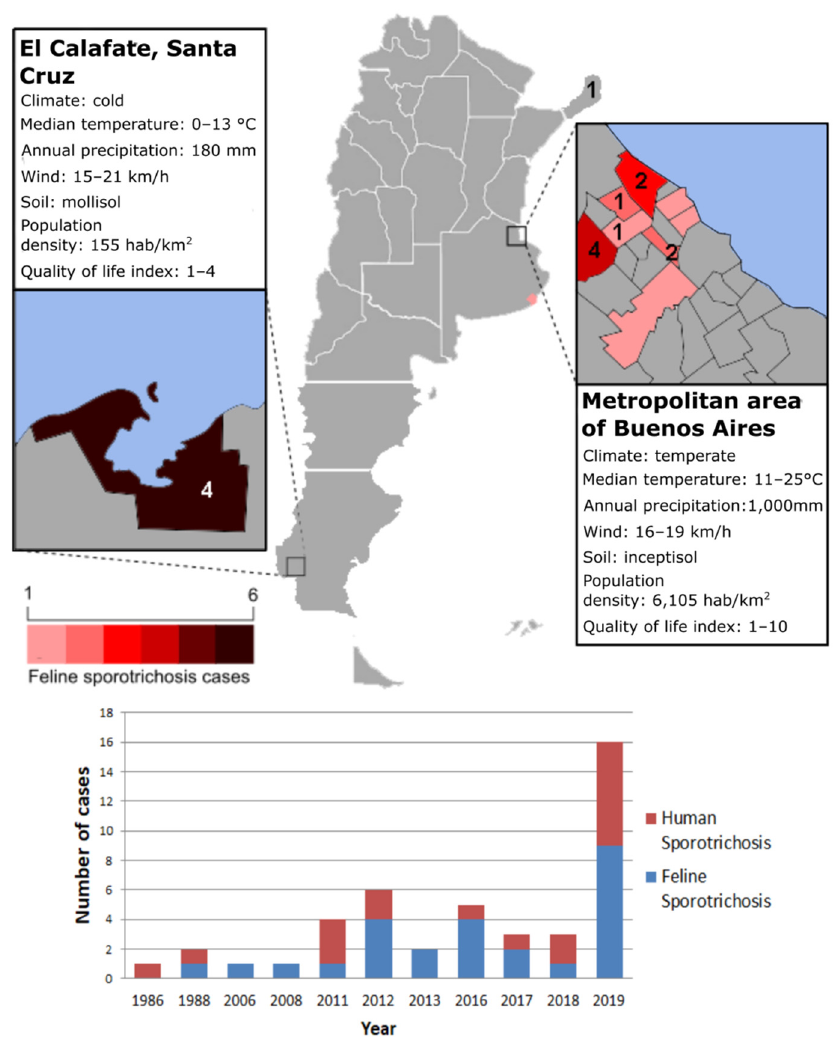
Figure 3. Distribution patterns and frequencies of S. brasiliensis in